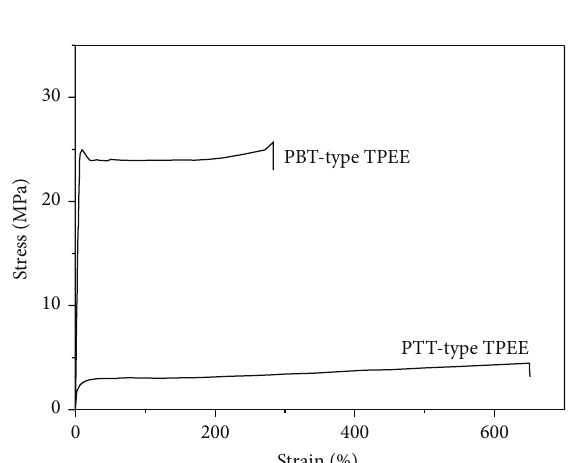
Figure 12: TG curves of two copolymers.